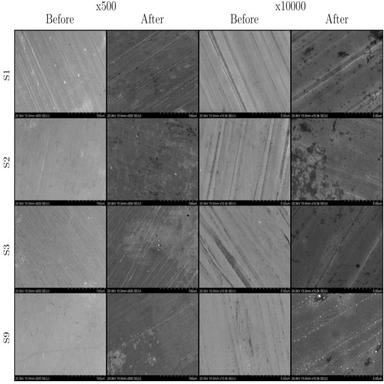
SEM images of 316 stainless-steel, before and after testing.